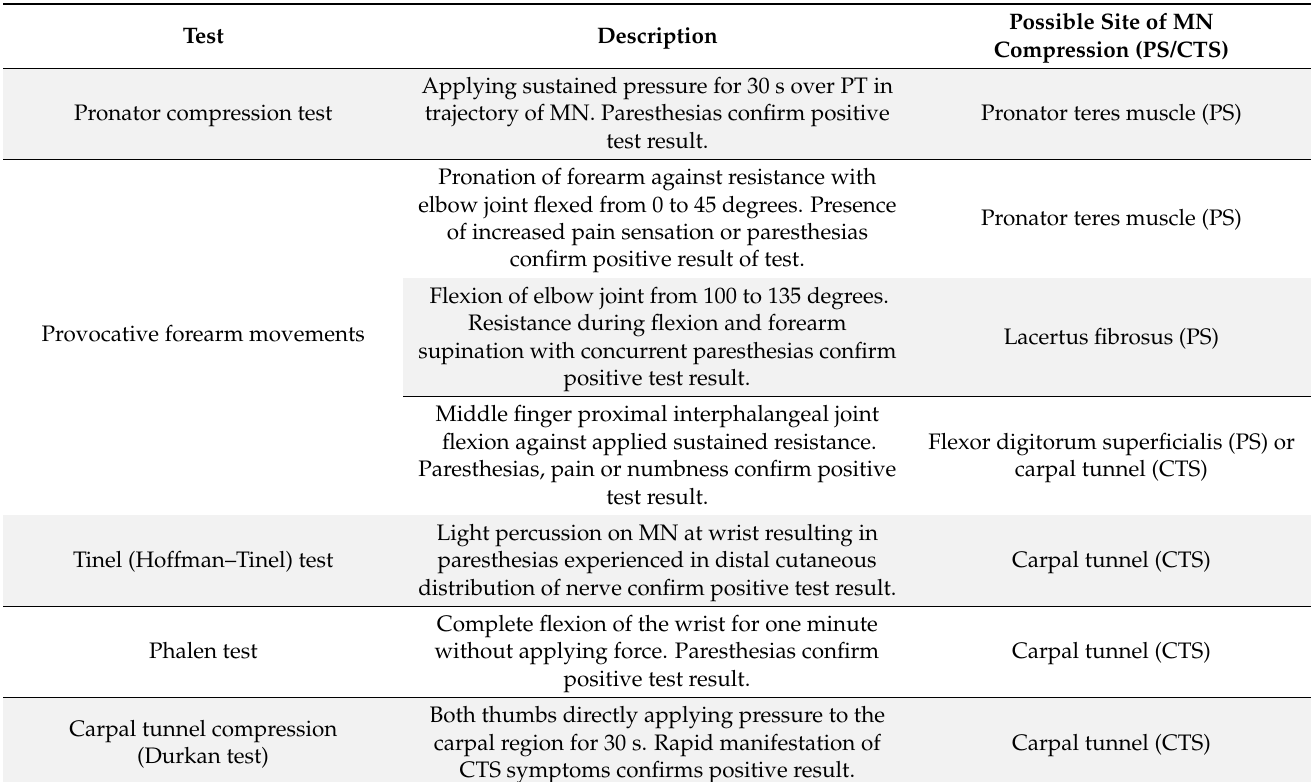
Table 2. Various tests performed during physical examination indicating possible sites of MN